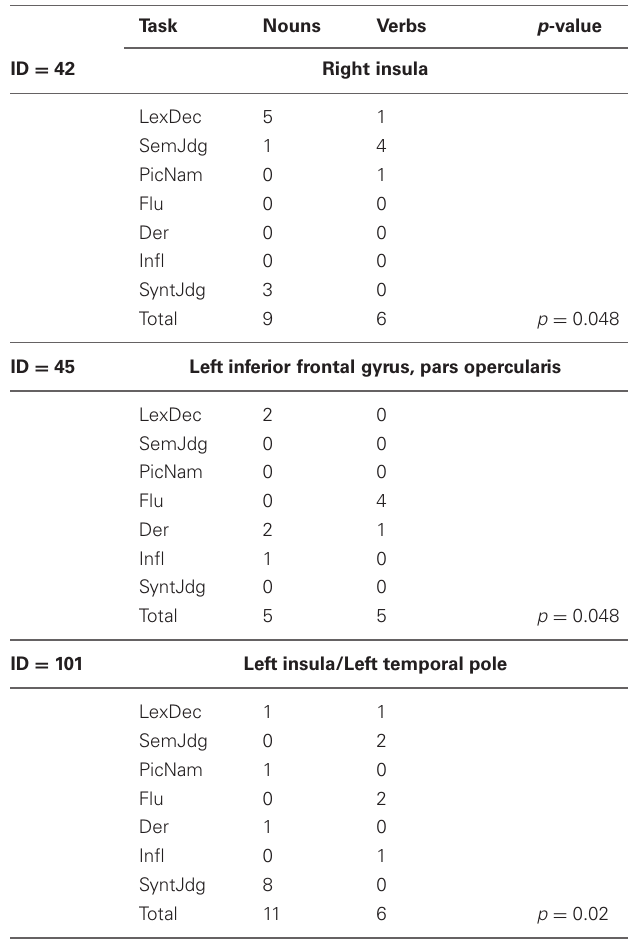
Table 4 | Task-by-grammatical class distribution of the activation peaks included in each of the five clusters showing interaction between these two